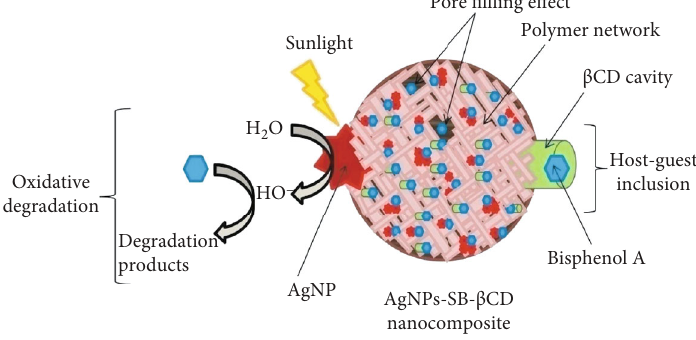
Figure 10: Illustration of the mechanisms for the BPA uptake onto AgNPs-SB- β